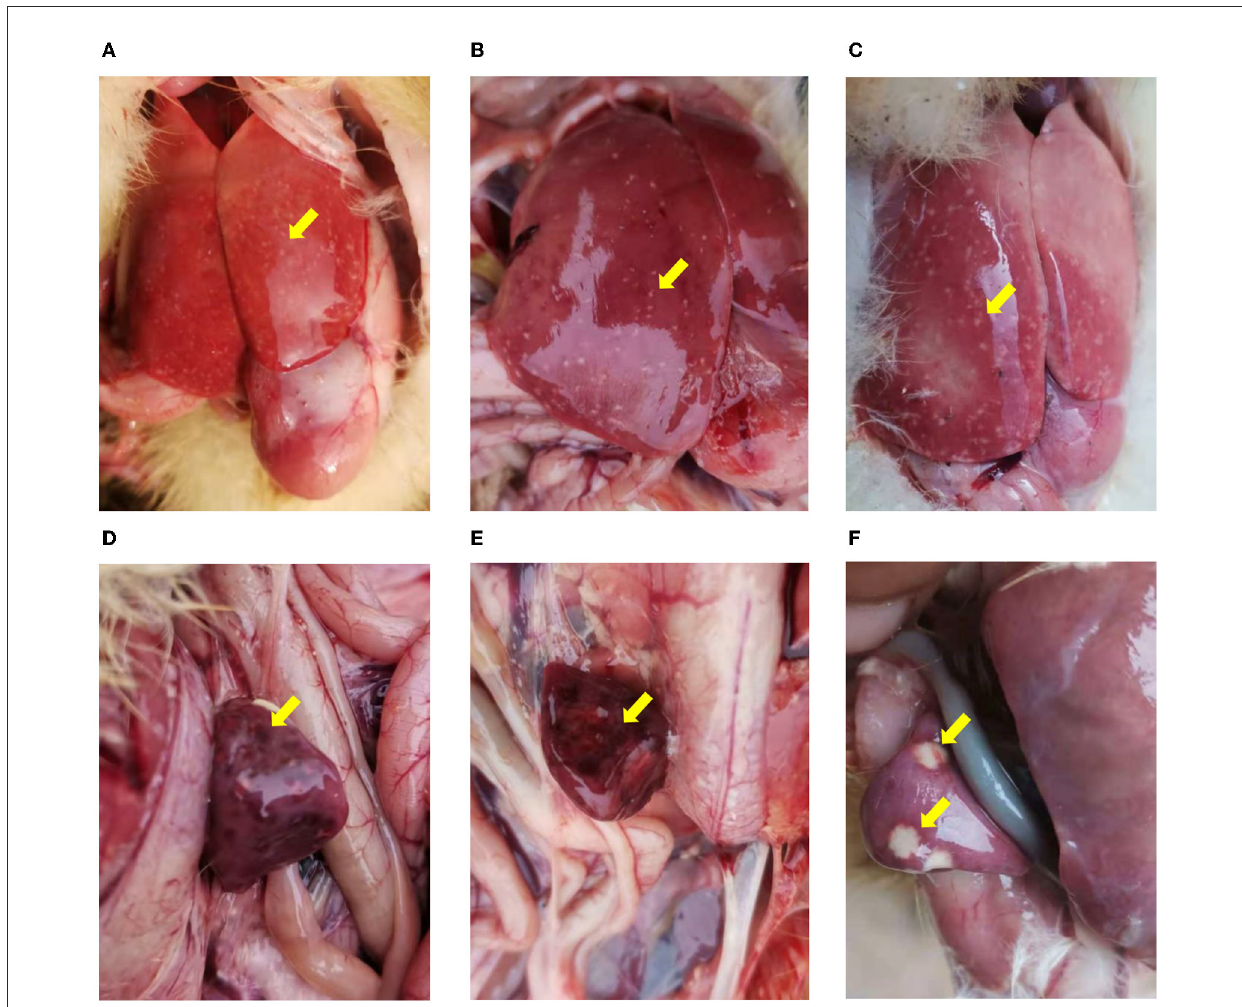
FIGURE1 The pathological changes of the infected ducklings. (A–C) Hemorrhage and necrosis in the livers. (D–F) Various degrees of congestion and necrosis in the spleens. (A, B, D, E) Collected from Xinxiang city (case 1). (C, F) collected from Jiaozuo city (case 2).